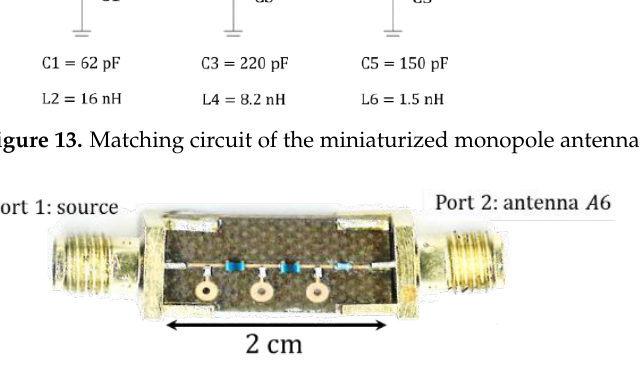
Figure 14. Realized matching circuit of the antenna A5. Figure 13. Matching circuit of the miniaturized monopole antenna A5 for the band 118 – 156 MHz.